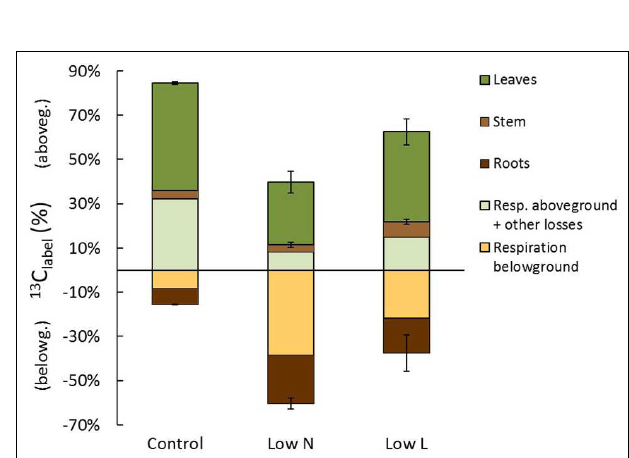
FIGURE 7 | Carbon allocation at the end of the chase period 13 days (310h) after labeling. The percentage of initially fixed 13 C from label ( 13 C label ) separated into C allocation to aboveground (positive) and belowground (negative). Shown are C losses (respiration and other losses: n = 1 ) and C in plant tissues (in leaves, stems, and roots; n = 2 ± SE).